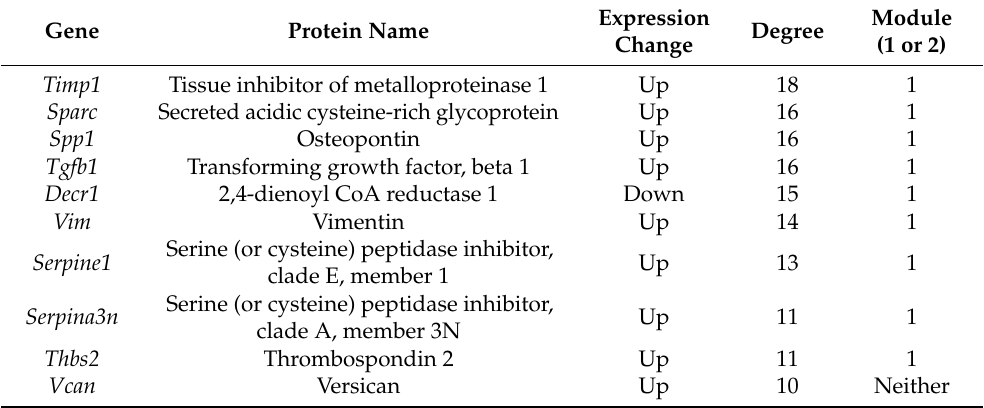
Table 4. Detail information of top 10 hub